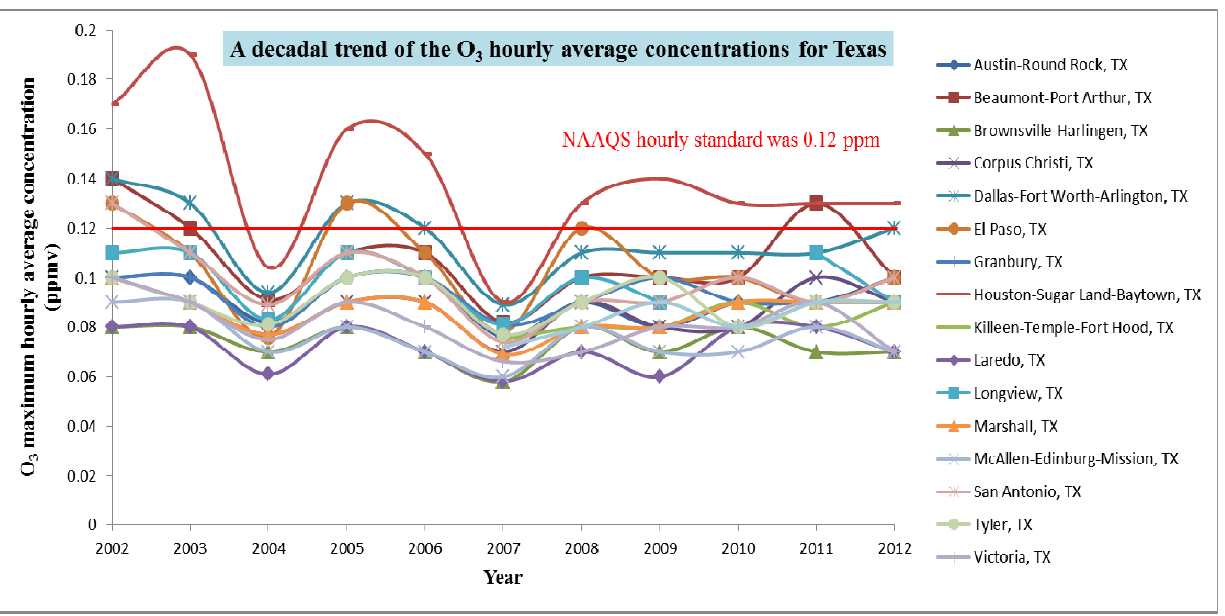
Figure 7. Air quality statistics- Maximum hourly average trend of Ozone in Texas for the last decade (data were obtained from US EPA